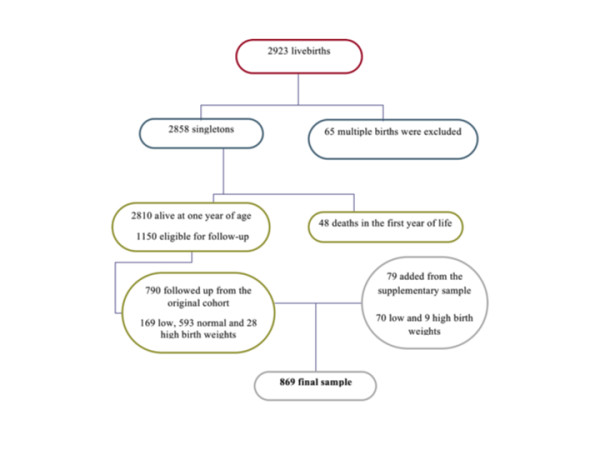
Flow chart diagram of Ribeirão Preto birth cohort baseline and follow-up.